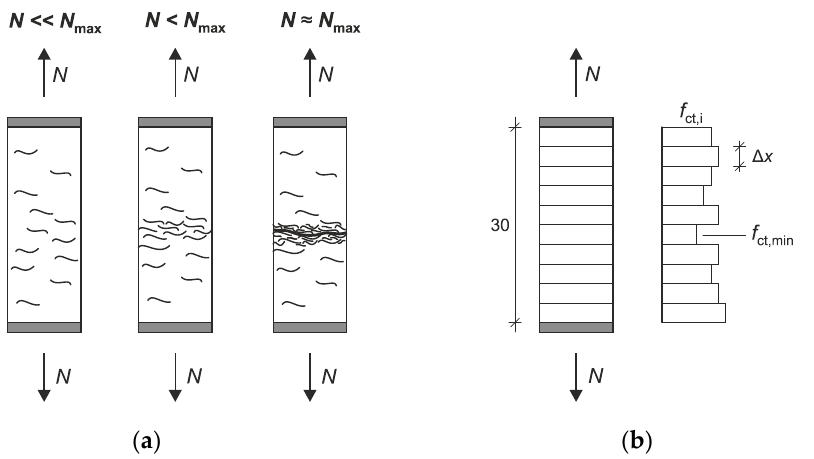
Figure 6. ( a ) Fracture of concrete under uniaxial tension [21]. ( b ) Distribution of specimen tensile strength [3].